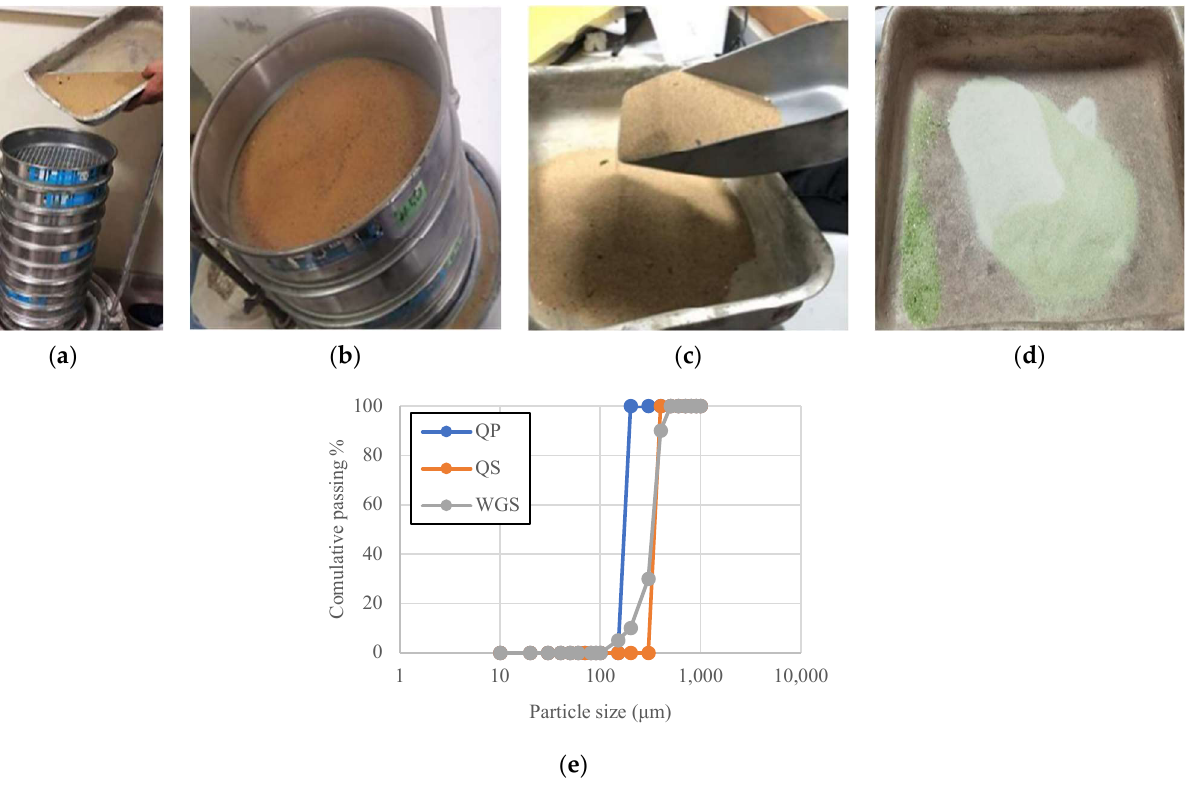
Figure 2. ( a ) Mechanical Shaker; ( b ) Sieving Apparatus; ( c ) Sieved Aggregates; ( d ) Waste glass sand; ( e ) Gradation curve for QP, QS, and WGS. Table 2. Mix Design.